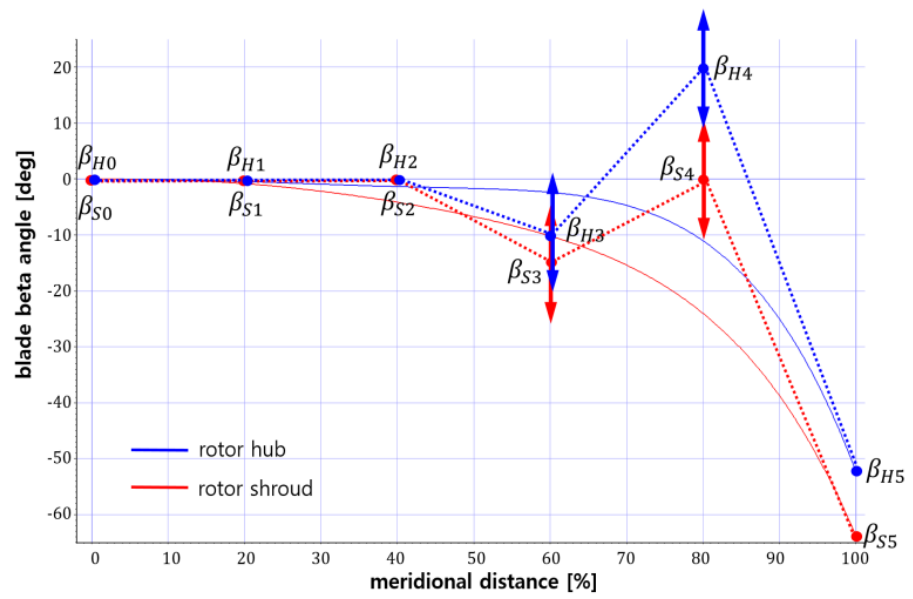
Figure 10. Blade β angle distributions controlled by Bezier curves. Figure 10. Blade 𝛽 angle distributions controlled by Bezier curves. Table 5. Design parameters and metamodel in each optimization